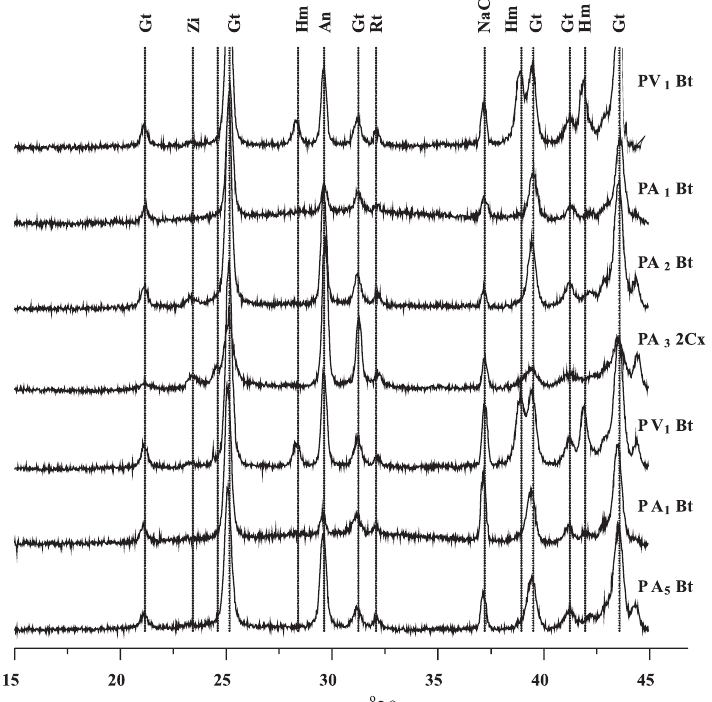
Figura 2. Difratogramas de raios X de concentrado de óxidos de ferro dos horizontes B de alguns solos estudados. Gt: goethita, Hm: hematita; An: anatásio; Rt: rutilo; Qz: quartzo; Zi: zircão; NaCl: padrão